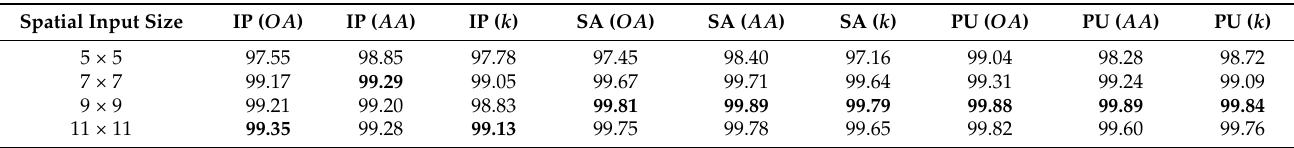
Table 10. Accuracy (%) of SSCRN under different spatial sizes of the input image patches on different datasets. Bold indicates the best